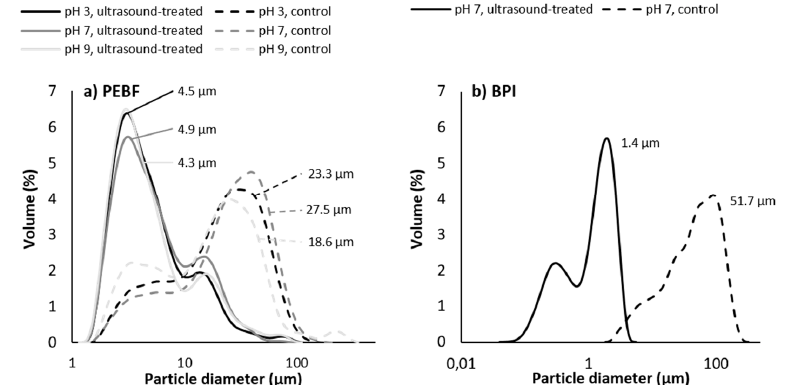
Figure 4. Impact of ultrasound treatment and pH on particle size distribution of ( a ) protein-enriched barley fraction (PEBF) and ( b ) barley protein isolate (BPI) at ultrasound-treatment pH. Median particle size of each sample is indicated next to the size distribution curve.